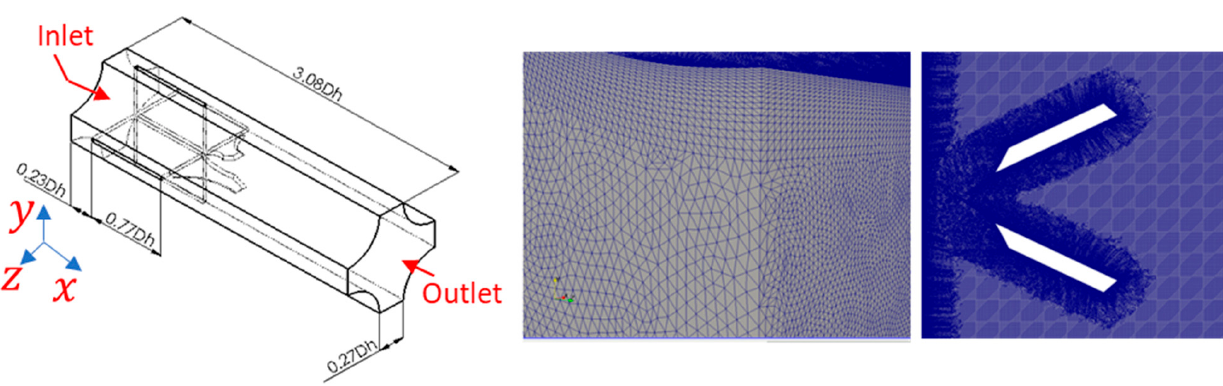
Figure 1. Pressurized water reactors (PWR) sub-channel geometry with spacer-grids and mixing vanes ( left ). Tetrahedral mesh, 367.5 M elements, with extended boundary layers on mixing vane surfaces also shown ( right ). Inlet cross-section located at x = 0.